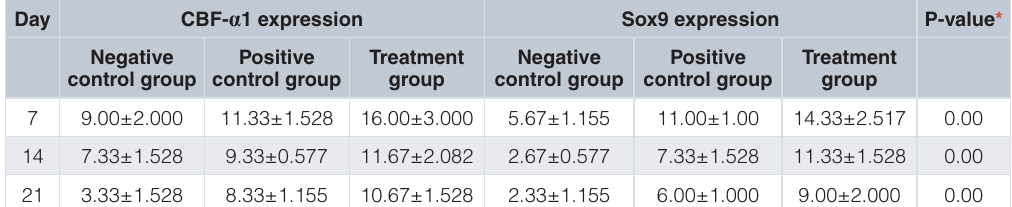
Table 1. CBF- α 1/Sox9 expression ratio between